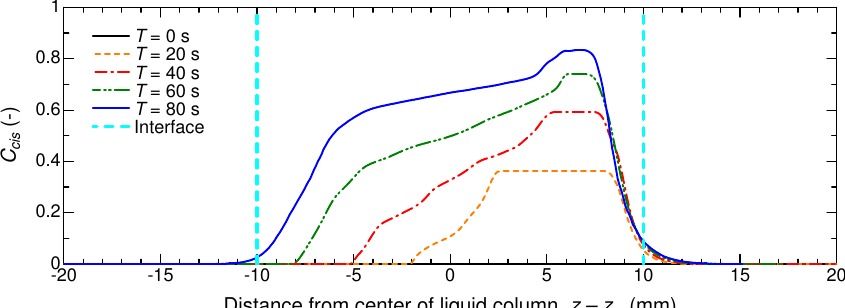
Figure 5. Temporal variation of C cis along the white dashed line in Figure 4 for L c = 20 mm. The horizontal axis represents the relative position with respect to the center of the liquid column. The interface on the UV-light irradiation side is located at z − z m ≈ 10 mm, and the opposite one is at z − z m ≈ − 10